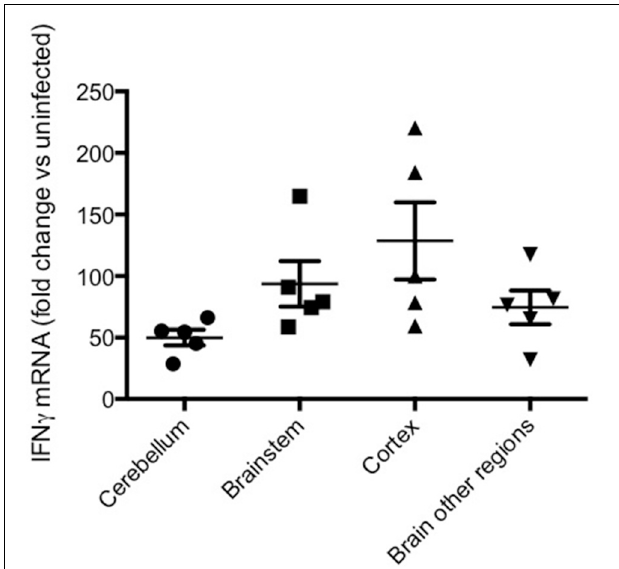
FIGURE 8 | Activation of endothelial indoleamine dioxygenase-1 by IFN- γ does not affect growth of co-cultured Plasmodium falciparum . Pf -PRBC or uninfected RBC (uRBC) were cultured together with human brain endothelial cells (line HBEC-5i) for 72h. Parasite growth as Plasmodium falciparum histidine rich protein-2 ( Pf HRP-2) was determined by ELISA. Under the same conditions,